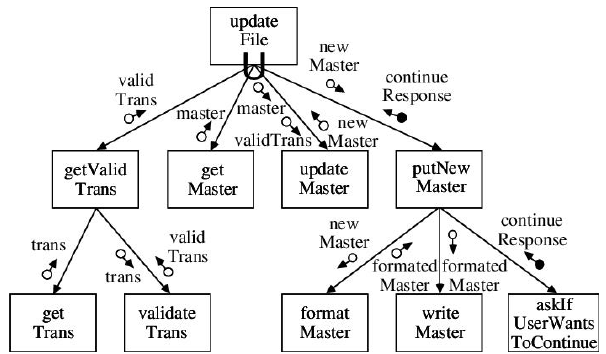
Fig. 4 Schematic diagram of menu